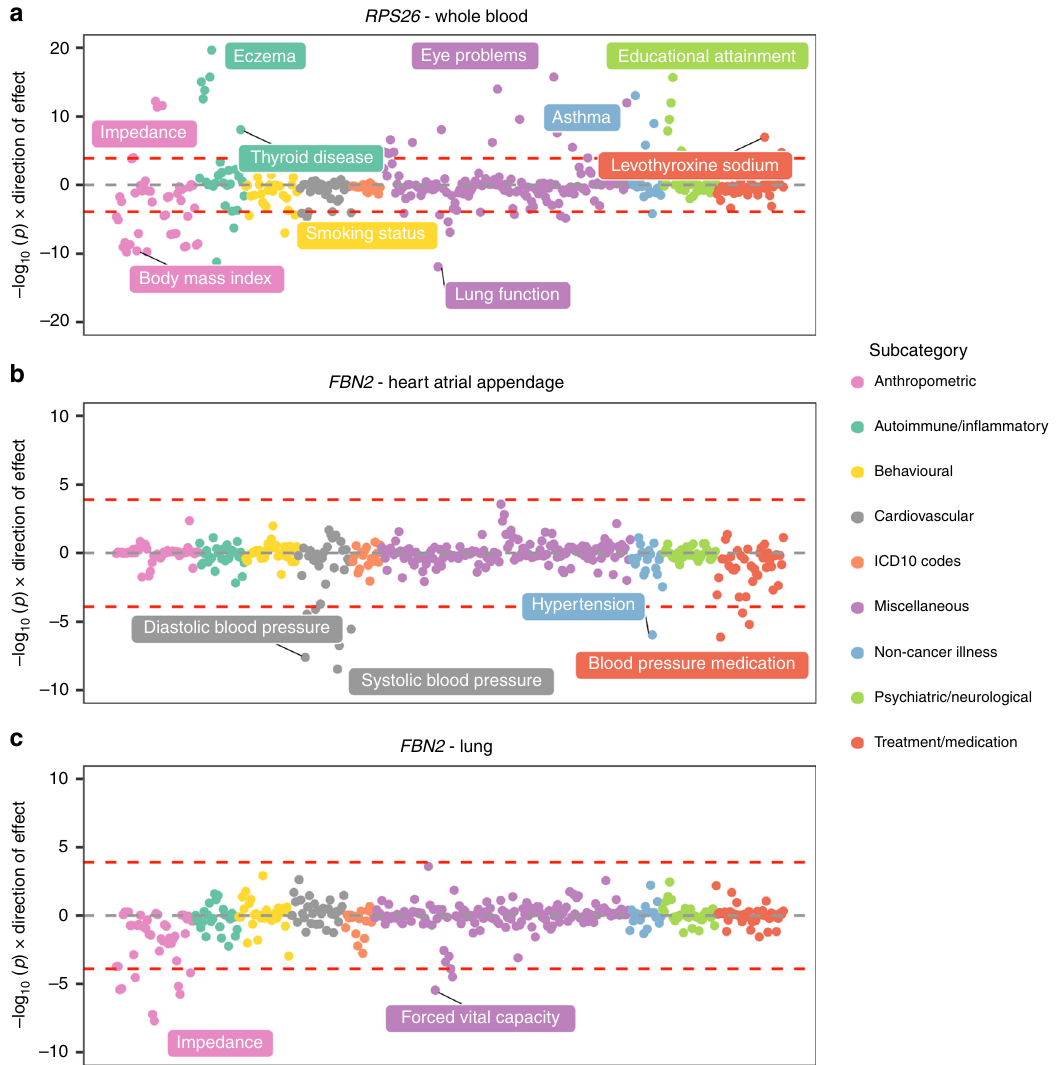
Fig. 5 Miami plots illustrating phenome-wide associations between genes in different tissue types. a RPS26 expression derived from whole blood was associated with many diverse traits, b FBN2 expression derived from heart tissue was associated with blood pressure traits, and c FBN2 associations with blood pressure attenuated when analysed using lung-derived data. However, associations with other traits were observed